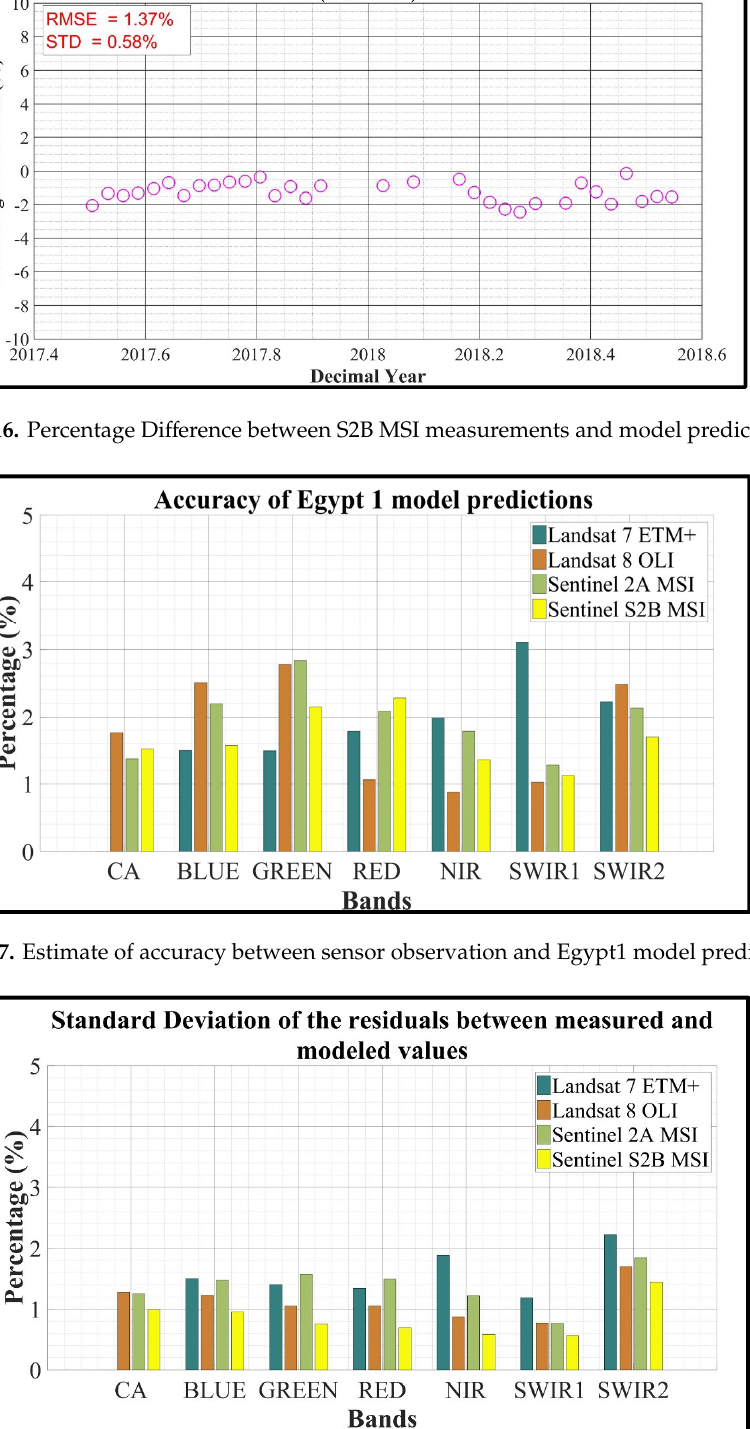
Figure 18. Estimate of precision of the Egypt 1 model for the selected sensor.